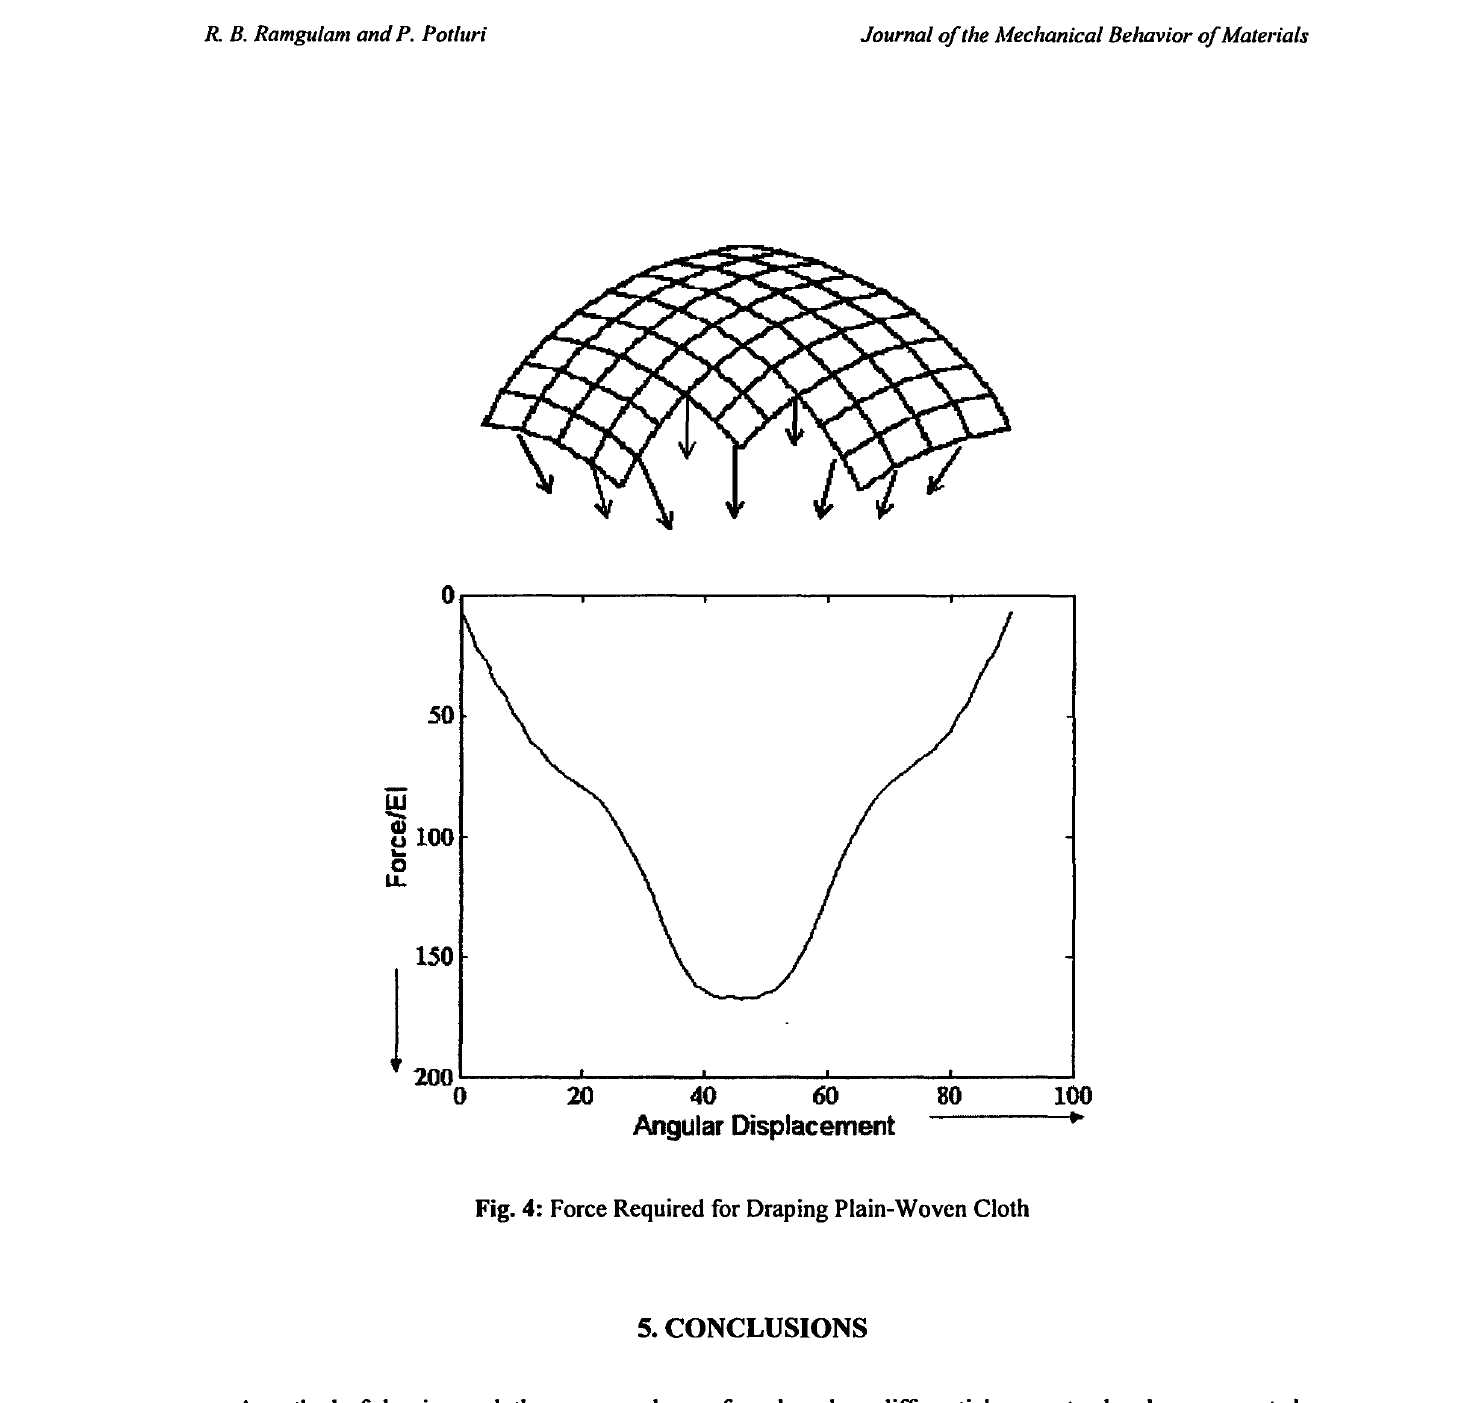
Fig. 4: Force Required for Draping Plain-Woven